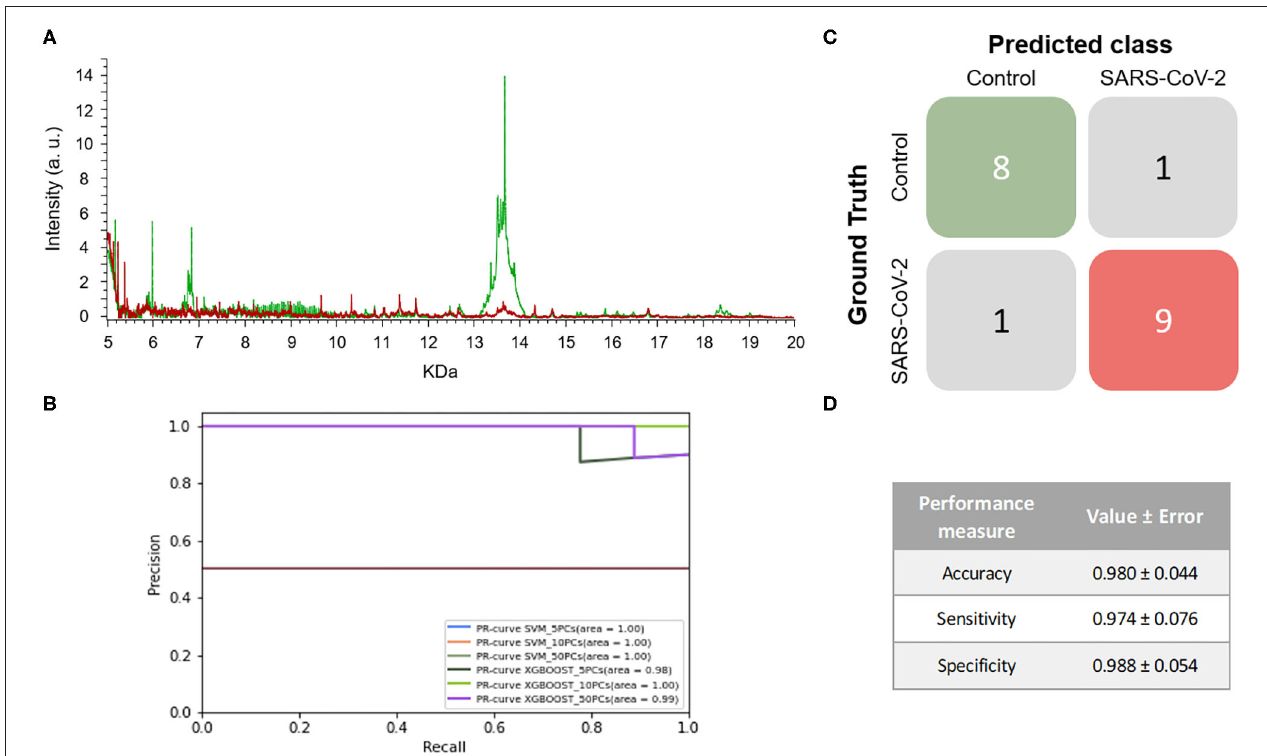
FIGURE 4 | Results for DeltaSwab-ViCUM (VTM1) within the high incidence pandemic period. (A) Representative mass spectra of NP samples for SARS-CoV-2: positive (red) and negative (green). (B) Precision-recall curve from the different models. (C) Average confusion matrix and (D) average performance metrics including their standard deviation (the test was performed 20 times selecting randomly different samples for each iteration) of the best model (SVM + 5PCs cross-validation K =